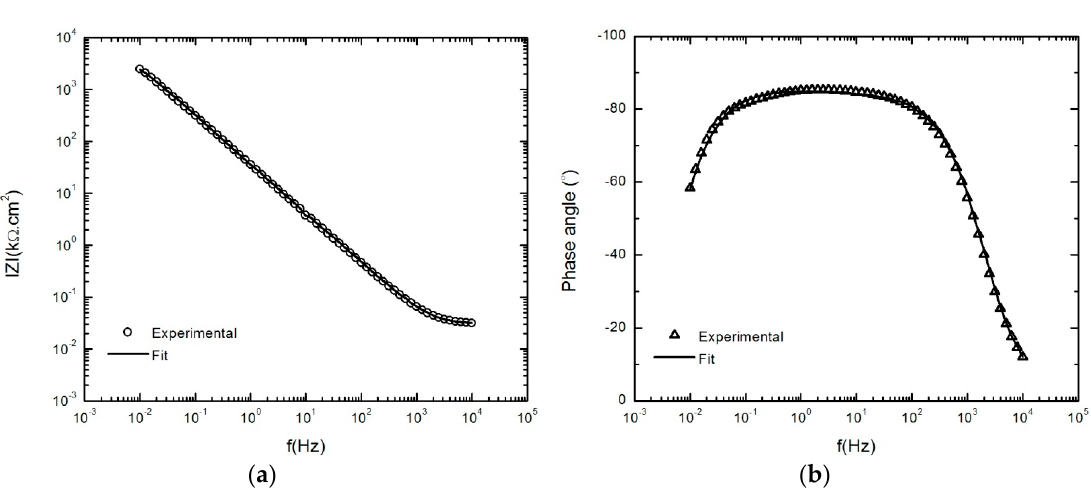
Figure 9. EIS measurements and model fits of the AA2098 – T851 alloy after 24 h immersion at 300mVSCE in NaHCO 3 solution in CO 2 atmosphere at 25 °C. ( a ) Bode magnitude and ( b ) Bode phase plots.